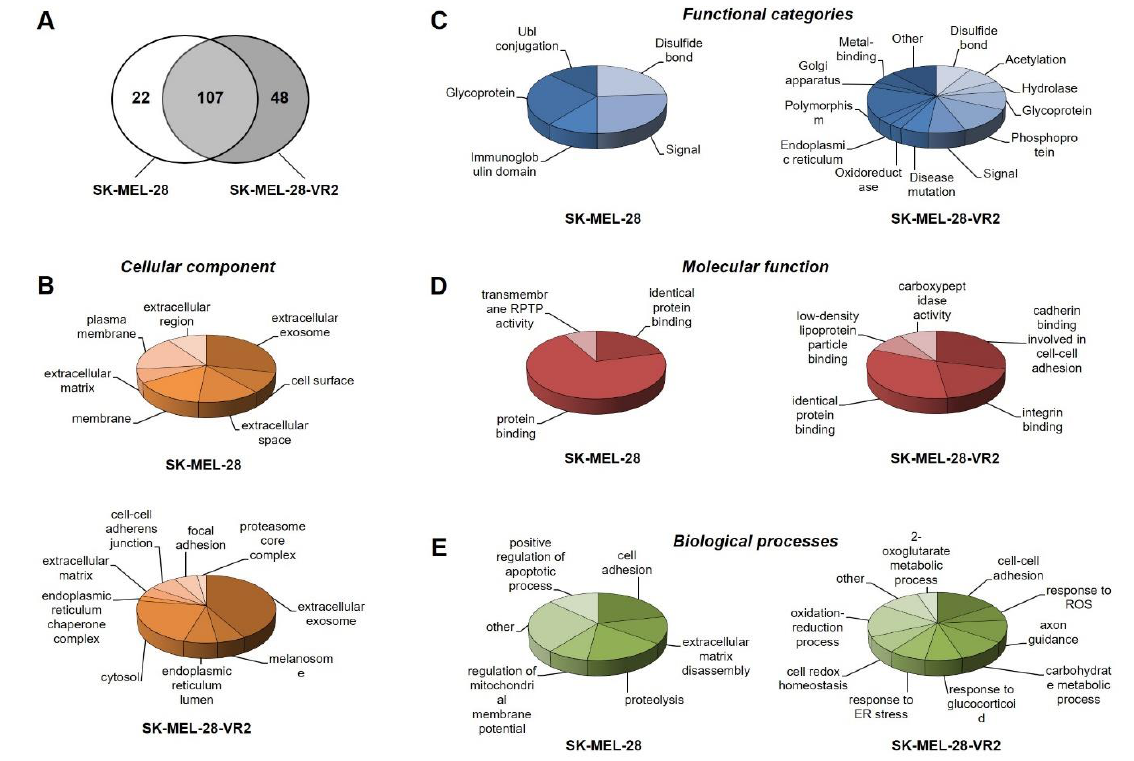
Figure 3. Secretome analysis of sensitive and vemurafenib-resistant melanoma cells. ( A ) The diagram illustrates common and differentially expressed (specific) proteins in SK-MEL-28 (sensitive) and SK-MEL-28-VR2 (vemurafenib-resistant) melanoma cells. The pie charts show Database for Annotation, Visualization, and Integrated Discovery (DAVID) classification of specific proteins based on ( B ) cellular component, ( C ) functional categories, ( D ) molecular functions, and ( E ) biological processes. Table 1. Specific (differentially expressed) proteins of parental and resistant